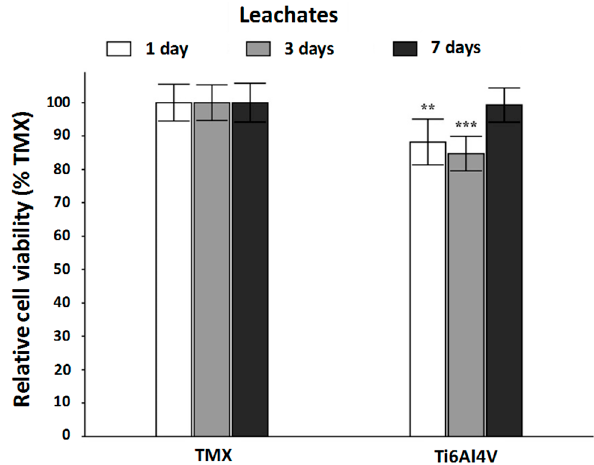
Figure 11. Results of the MTT assay test for human osteoblast cultures maintained with leachate at 1, 3 and 7 days obtained from samples of the control TMX and study materials (** p < 0.01; *** p < 0.001).